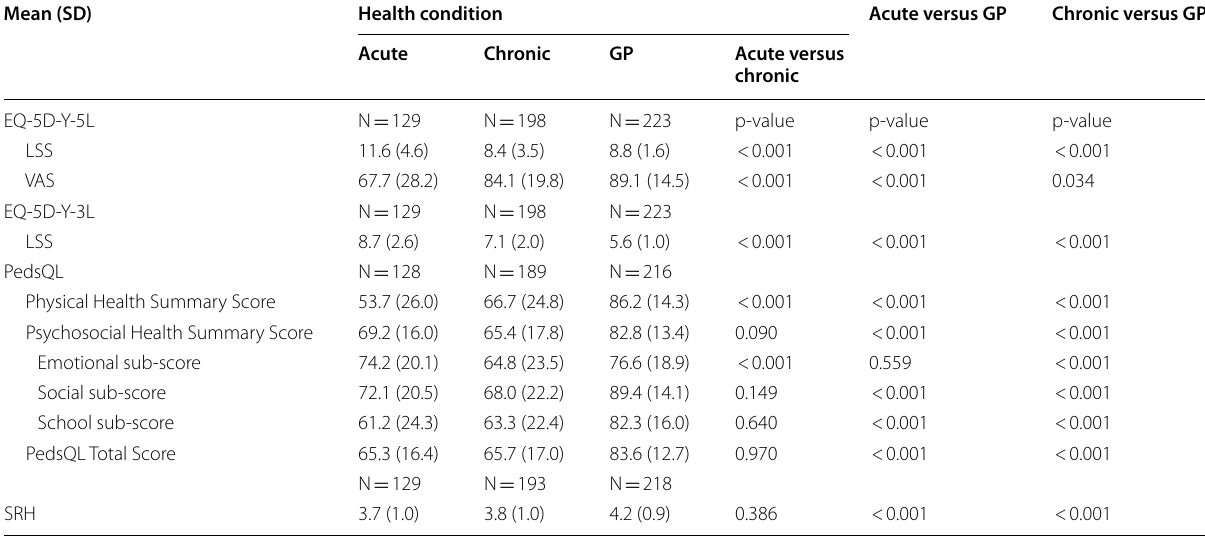
Table 5 Comparison of known-group validity for health condition across the EQ-5D-Y-5L, EQ-5D-Y-3L, PedsQL and Self-Rated Health (SRH)